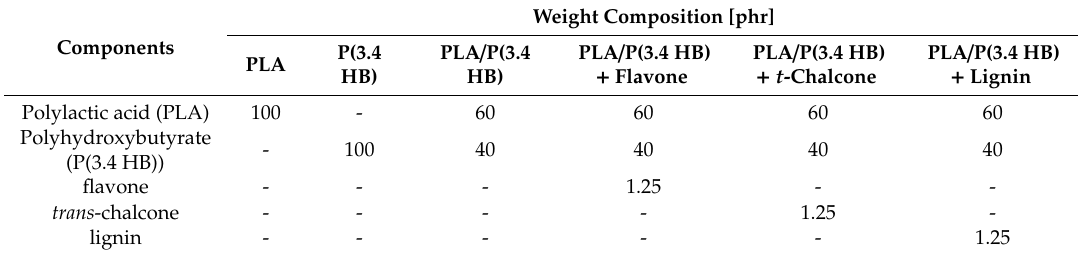
The composition of prepared polylactide / polyhydroxybutyrate samples containing natural